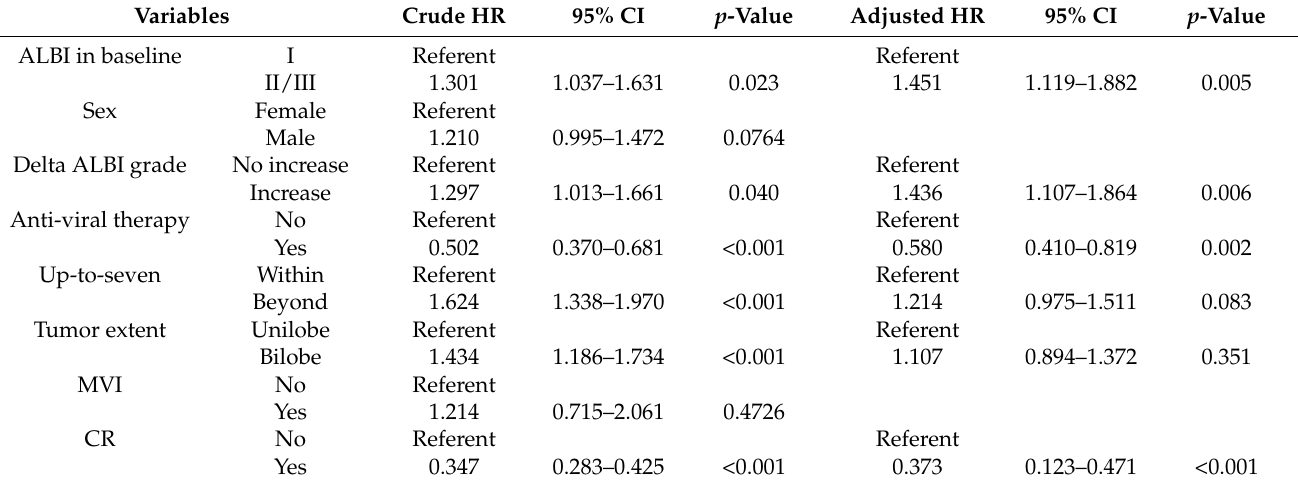
Table 2. Cox regression of risk factors associated with mortality in HCV patients.